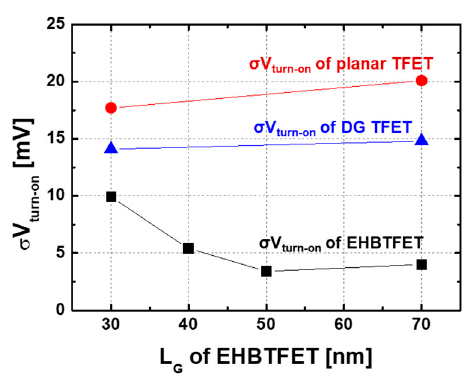
Figure 6. The σ V turn-on of the planar TFET, DG TFET, and EHBTFET when the L G is changed. While reducing the L G , the L CH is reduced by the same length, and L UD and L US are kept at 20 nm.